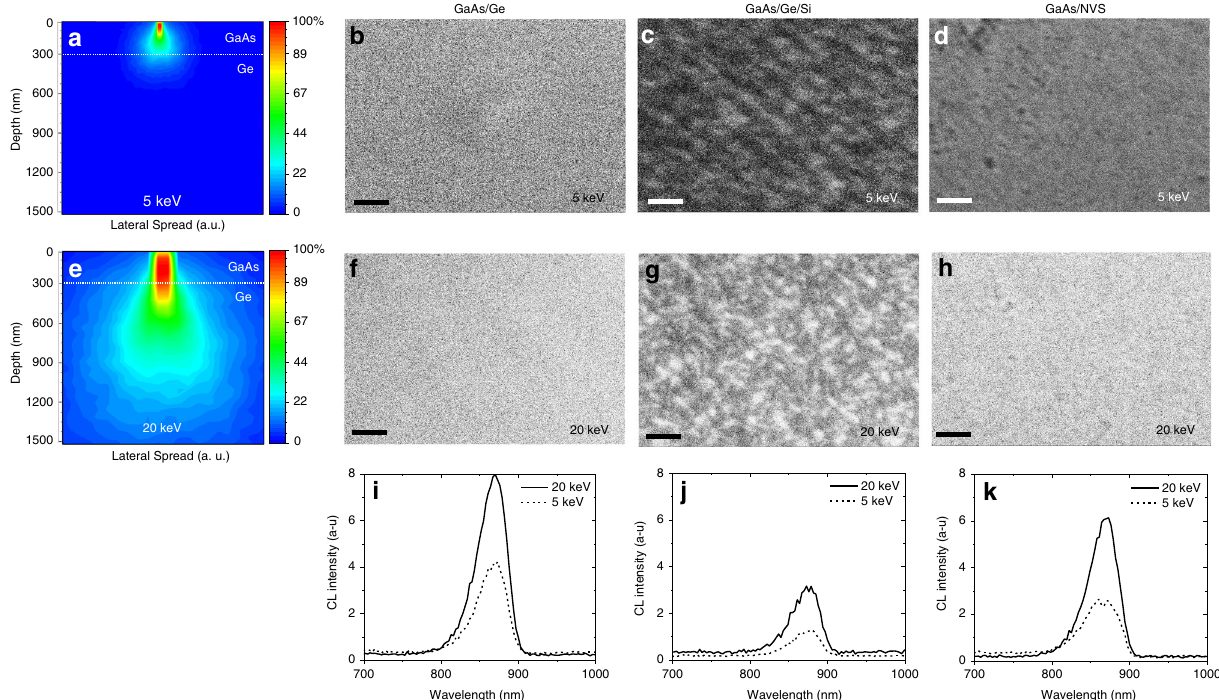
Fig. 7 Effect of reducing dislocations on optical properties. Monte-Carlo simulations using CASINO software of the electron interaction volume, and planar cathodoluminescence (CL) micrographs of a 300 nm-thick GaAs layer grown on bulk Ge substrate, Ge/Si substrate, and the NVS at 5 keV ( a – d ) and 20 keV ( e – h ), respectively. The color scale bar in a , e shows the electron concentration. The CL micrographs in b – h show the emission and the recombination behavior at the surface (5 keV) and in the bulk (20 keV) of GaAs on each substrate. Scale bars 3 µ m. Room temperature cathodoluminescence spectra recorded from i GaAs/Ge, j GaAs/Ge/Si with a TD density of ~10 7 cm − 2 and k GaAs/NVS with a TD density of ~10 4 cm − 2 , at 5 and 20 keV. CL measurements con fi rm that the dislocations were effectively blocked from propagating using nanovoids, which is re fl ected by an enhancement of the emission ef fi ciency of GaAs grown upon the comparison: bulk Ge, commercial Ge/Si with a TD density of ~10 8 cm − 2 and the NVS with a TD density of ~10 4 cm − 2 . Light